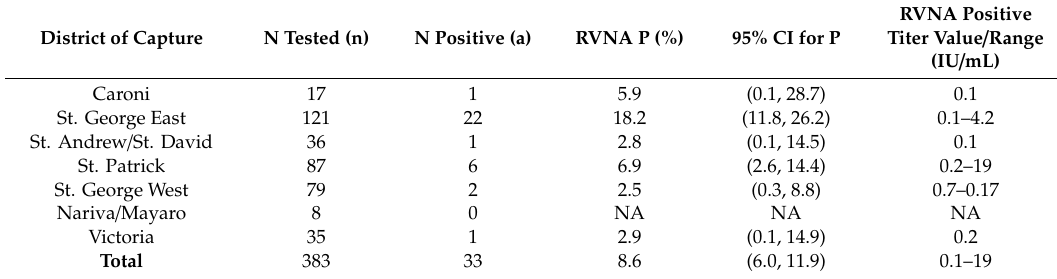
Table 1. RVNA prevalence and positive titer values by location (County) of capture.